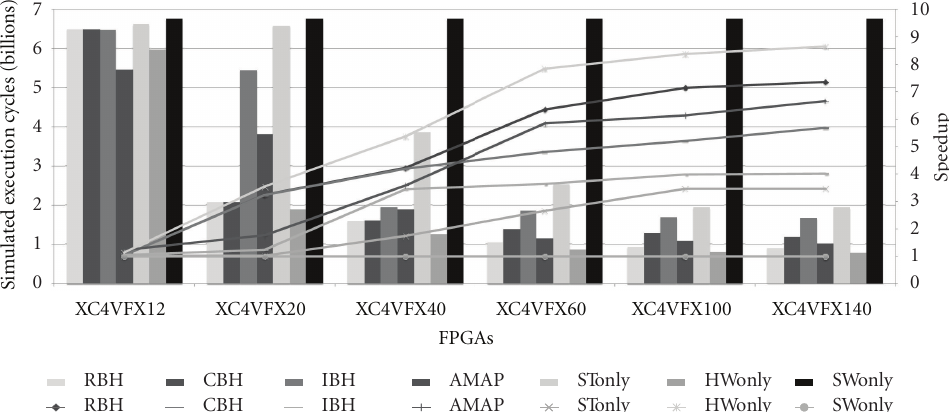
Figure 4: Comparison of the di ff erent heuristics tested in the proposed case study under di ff erent FPGAs conditions in terms of simulated execution time with corresponding application speedup. The application performance is proportional to the FPGA size. HWonly mapping has the best performance followed by RBH, AMAP, CBH, and IBH. STonly has the worst